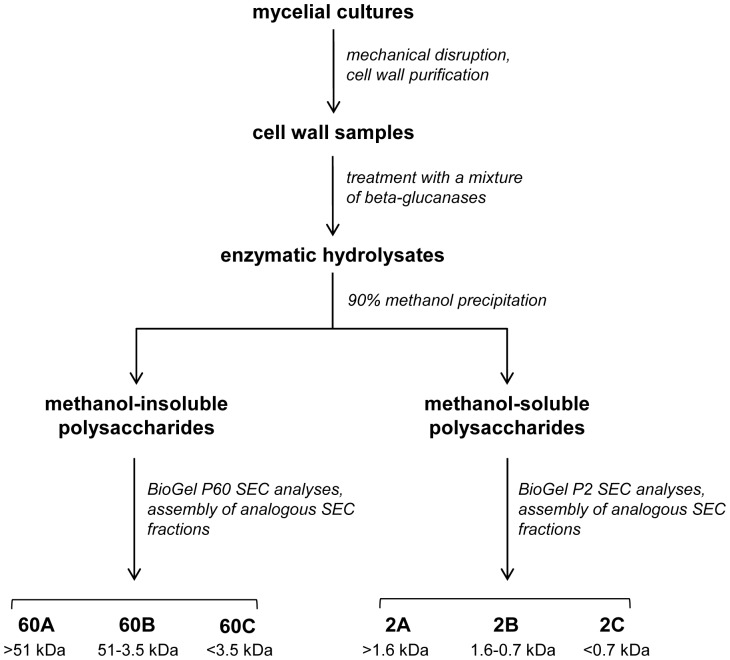
Preparation process of cell wall glucan-chitosaccharide fractions.